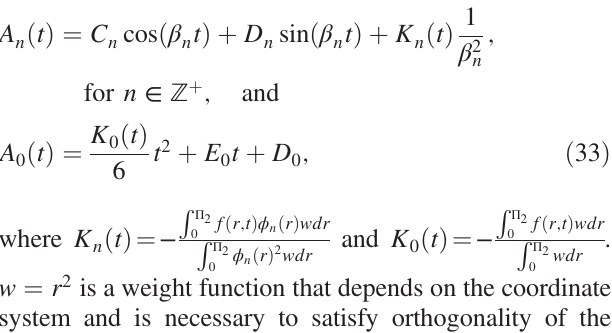
FIG. 5. Plot of E versus Π 4 showing the value of Π 4 ∼ 3 . 88 at err which the general solution becomes indistinguishable from the quasistatic